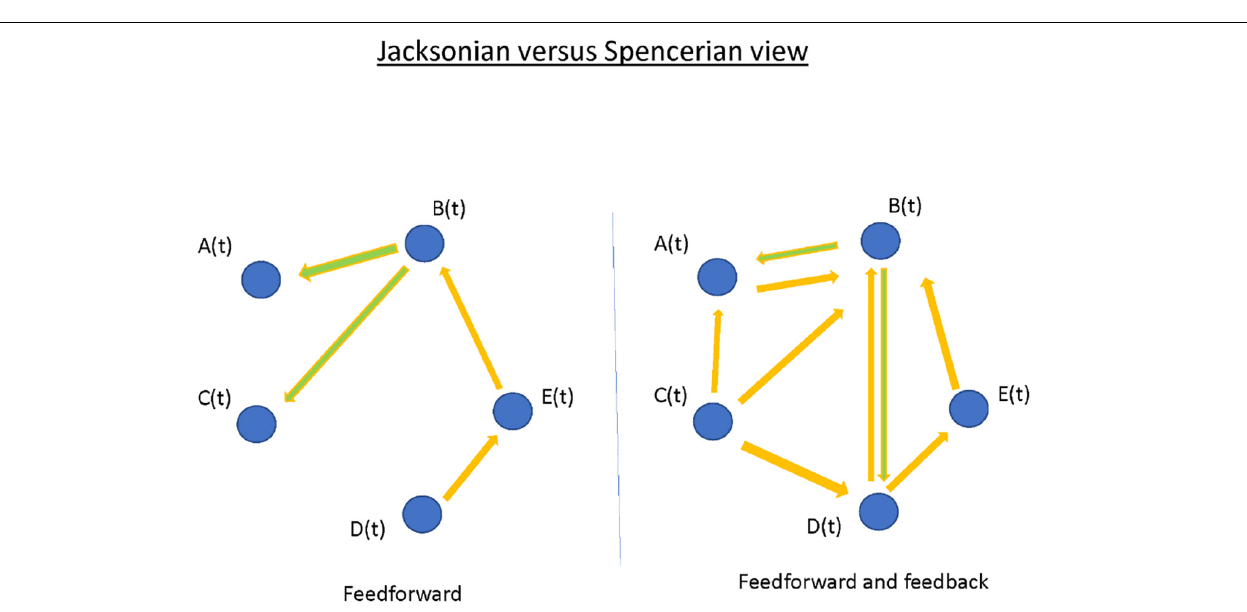
FIGURE 8 | Closed-loop but not Open-loop group was able to maintain the target ECAP level in the clinic and well as in the out of clinic environment.